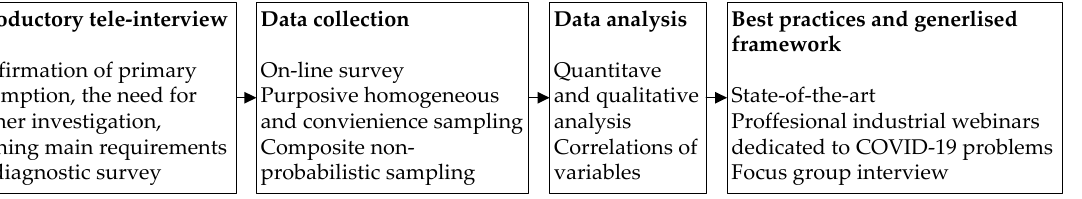
Figure 2. Research procedure.